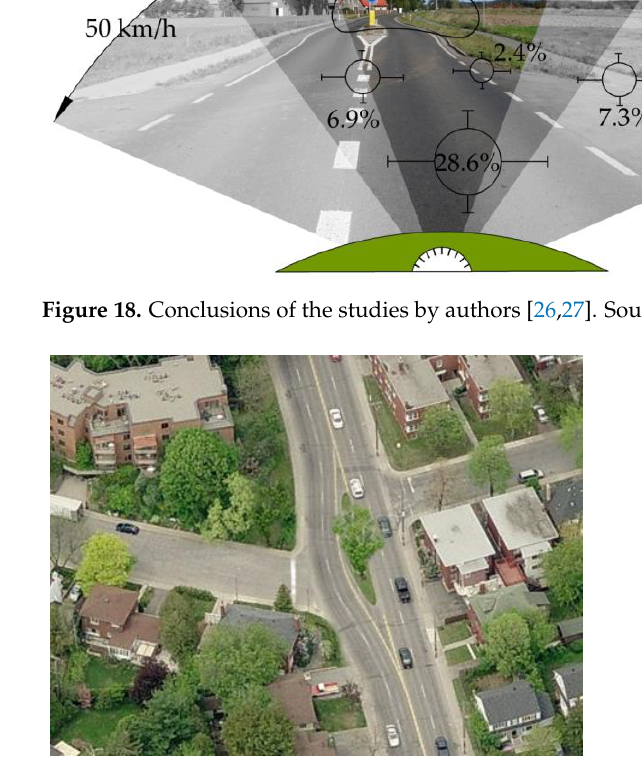
Figure 19. Example of a chicane containing vegetation. Source: Google Earth [61].